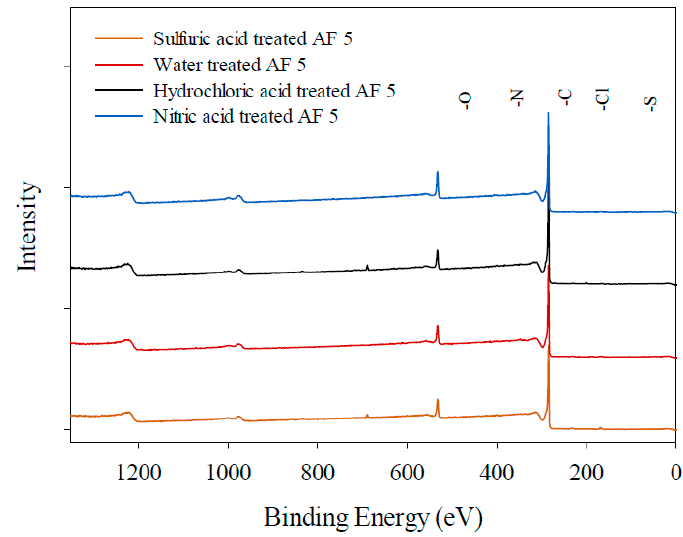
Figure 3. XPS spectra of AF 5 with different pre-treatment.